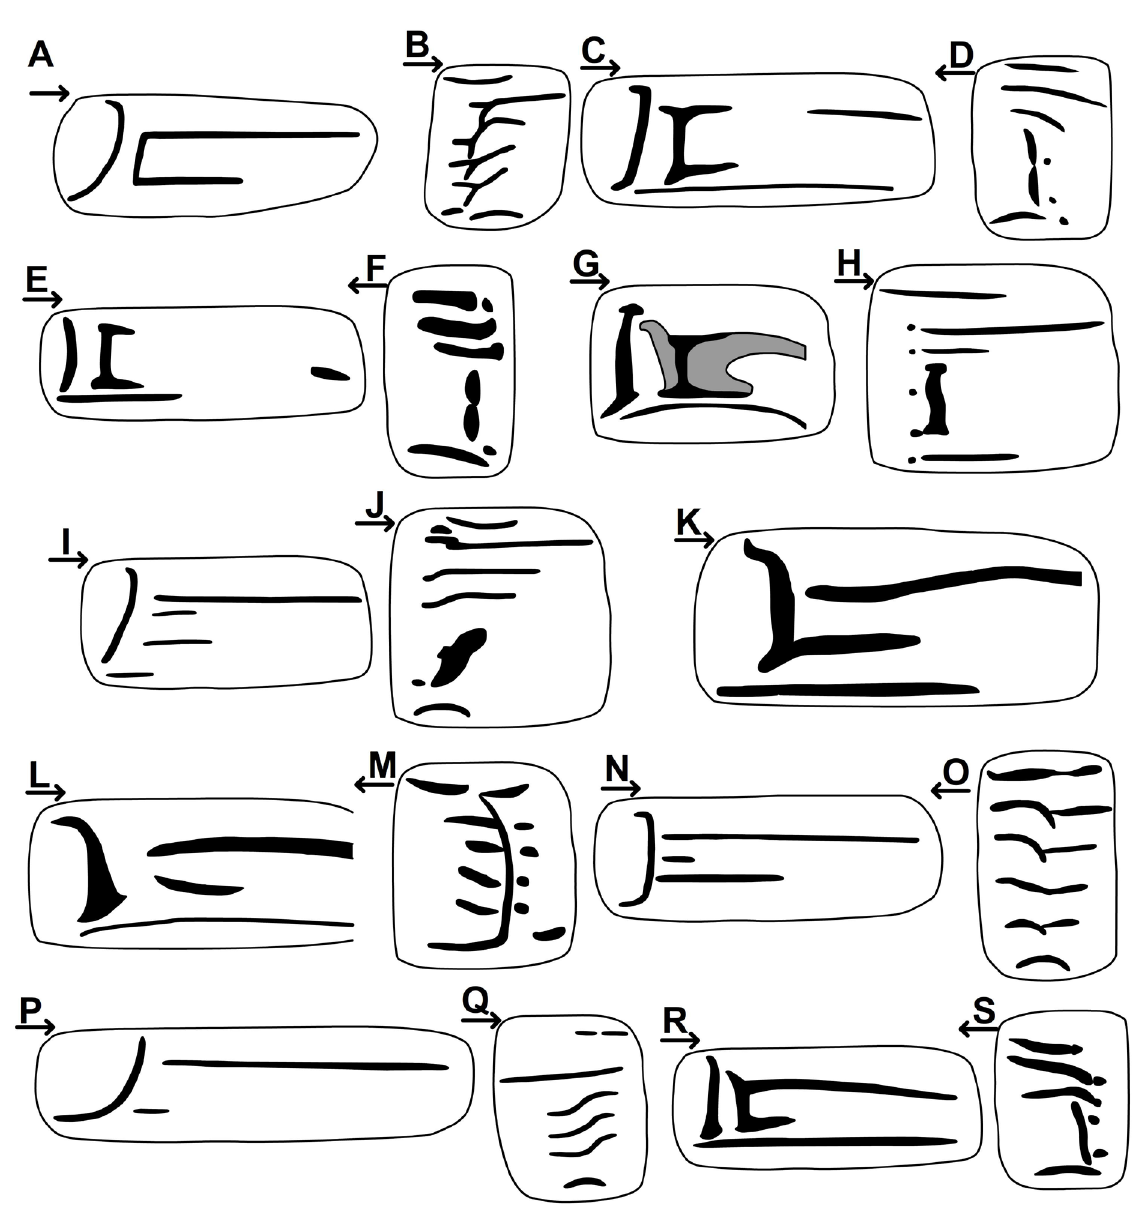
Fig. 15. Parietal (A, C, E, G, I, K, L, N, P, R) and palatal (B, D, F, H, J, M, O, Q, S) plication of species of Chersaecia Gude, 1899. A–B . C. auffenbergi sp. nov. (UF 448572). C–D . C. feddeni (Blanford, 1865) comb. nov. (after Gude 1914b). E–F . C. feddeni (“ Plectopylis ponsonbyi ”, after Gude 1896b). G–H . C. goniobathmos (Ehrmann, 1922) comb. nov. (SMF 150100c). I–J . C. leiophis (Benson, 1860) (NHMUK 1902.02.02.145). K . C. leiophis (“ pseudophis ”, after Gude 1914b). L–M . C. leiophis (“ kengtungensis ”, after Gude 1914b). N–O . C. leiophis (UF 446988). P–Q . C. leiophis , holotype of Plectopylis degerbolae Solem, 1966 (ZMUC-GAS-485). R–S . C. leucochila (Gude, 1897) comb. nov. (NHMUK 1922.8.29.39). Arrows below the letters indicate the direction of the aperture. Not to